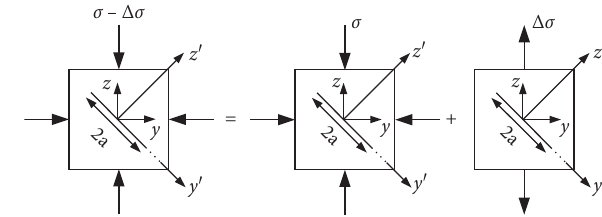
Figure 4: Superposition of stress intensity factor.